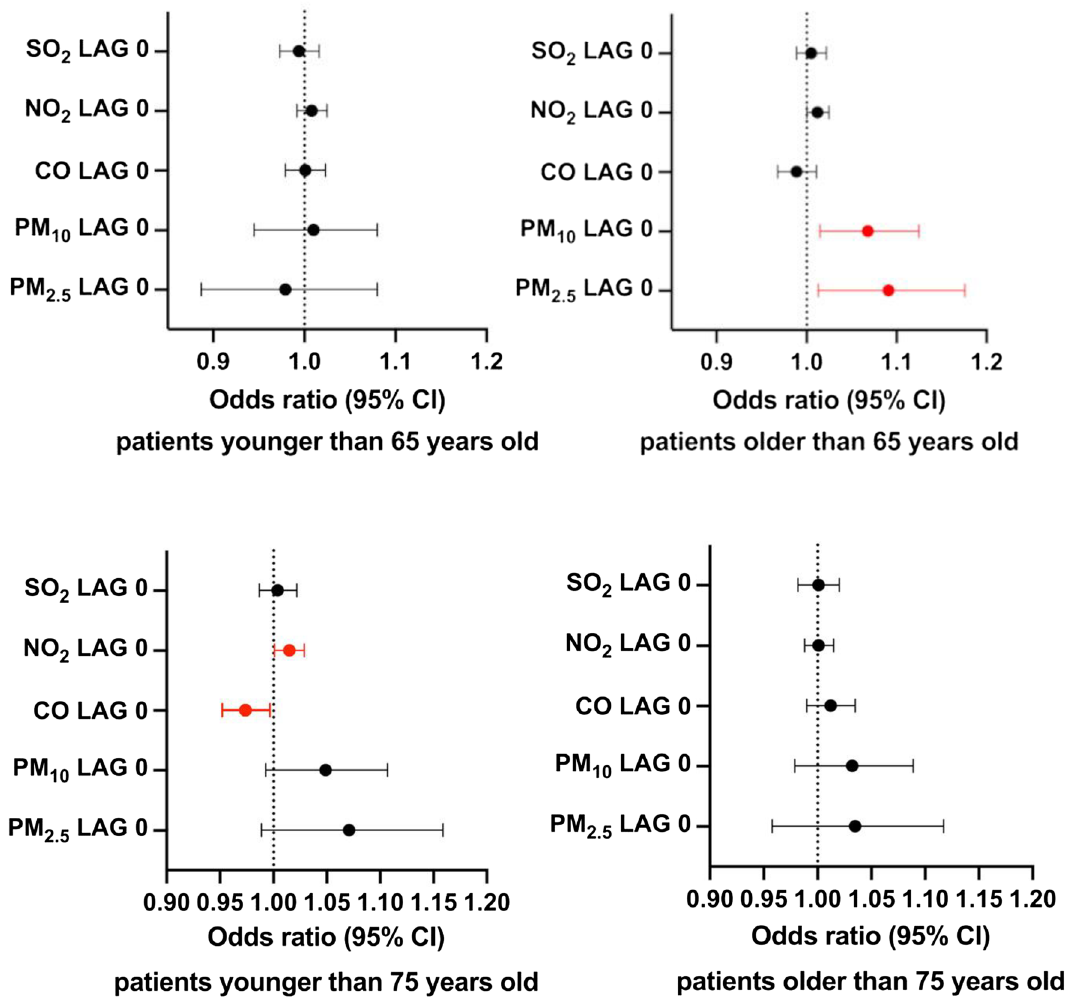
Figure 2. Associations between the exposure to short-term pollutants and ischemic stroke incidence in the study group divided by age.